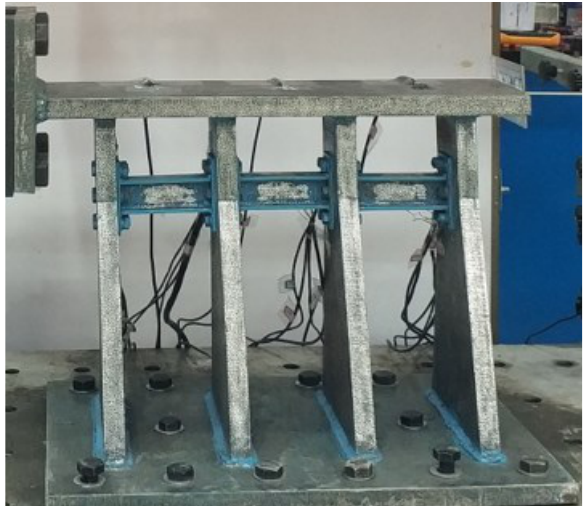
Figure 7. Deformation of the specimen during loading.